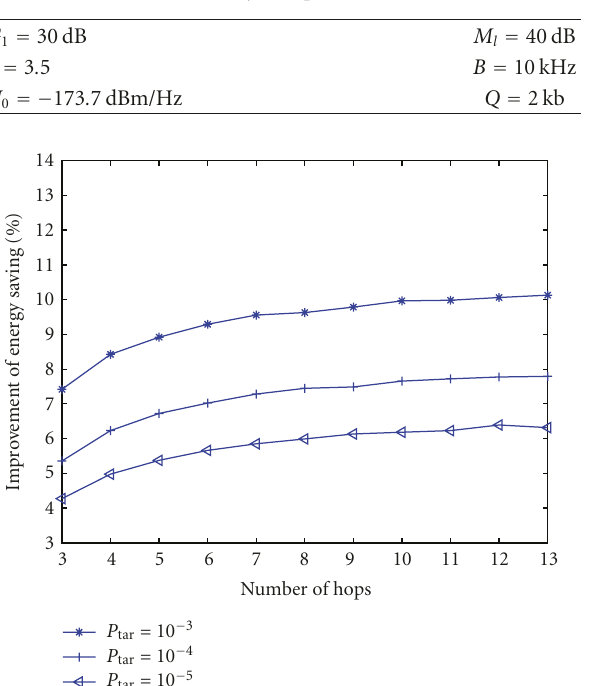
Table 1: System parameters.